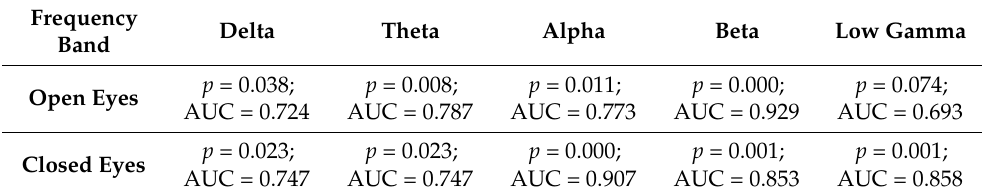
Table 4. AUC with conditions EO/EC compared to patients.